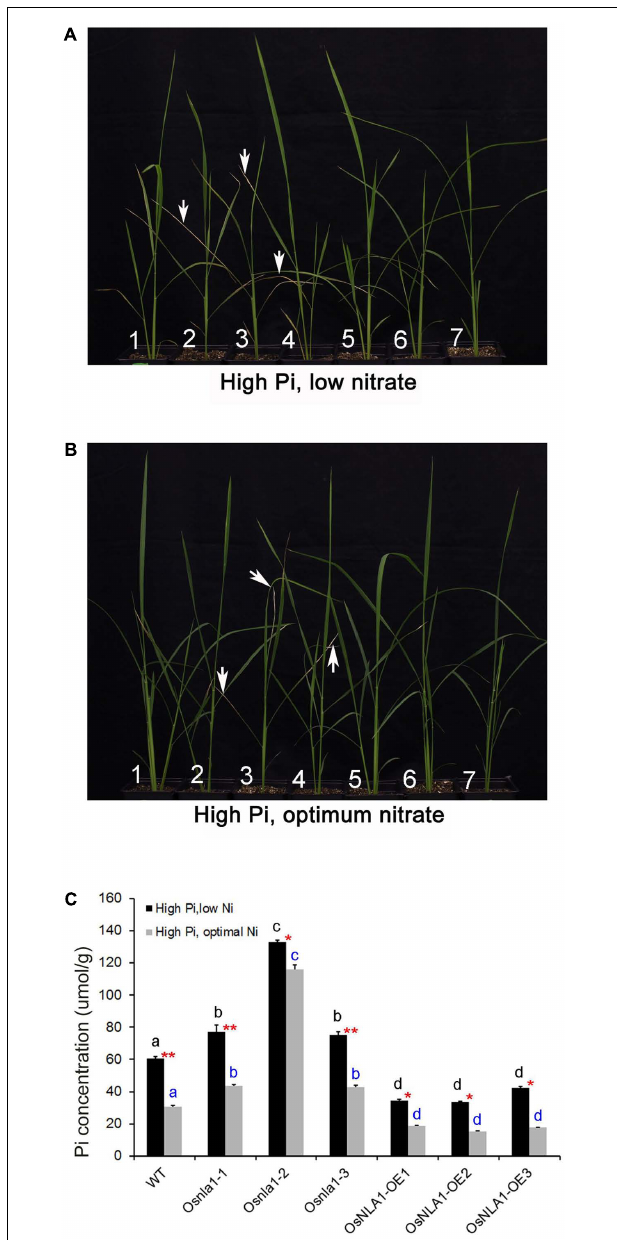
FIGURE 5 | Pi accumulation and subsequent Pi toxicity symptoms of OsNLA1 transgenic lines under combined high phosphate and low nitrate treatments. Two sets of soil-grown plants that included 1 - wild-type, 2 - osnla1-1 , 3 - osnla1-2 , 4 - osnla1-3 , 5 - OsNLA-OE1, 6 - OsNLA-OE2, and 7 - OsNLA-OE3 were grown in two different treatments with combination of Pi and nitrate together for 4 weeks. Knockdown lines showing chlorosis/necrosis patches at the tip of the leaf blade (arrows) under (A) combined high Pi and low nitrate, and (B) combined high Pi and optimum nitrate treatments. (C) Pi content of the shoot of plants; knockdown lines have the greatest Pi accumulation, whereas, over-expression lines have the least accumulation. For each genotype, low nitrate treatment significantly increased Pi concentration in shoots of plants (significance level of P ≤ 0.05 and P ≤ 0.01 denoted by ∗ and ∗∗ , respectively; two sample t -test). Different letters indicate a significant difference at P ≤ 0.05 level between genotypes within a growth condition (ANOVA, LSD test). Data are means ± SD of three to five replicates ( n = 3–5).